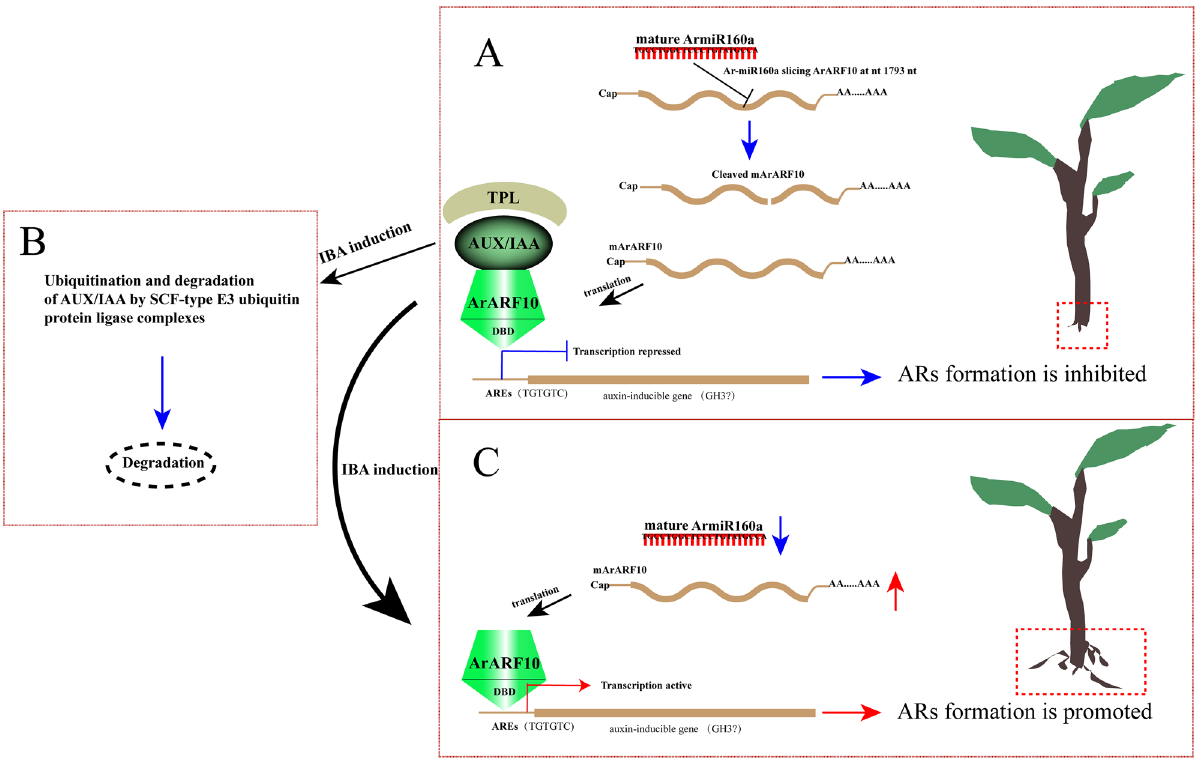
Figure 8. Schematic presentation of the regulation of AR growth in A. rubrum . ( A ) Under low auxin conditions, Ar-miR160 specifically cleaves mRNA- ArARF10 to repress ArARF10 expression, while Aux/IAA prevents auxin-inducible gene transcription by recruiting TPL to co-inhibit the binding of ArARF10 AREs in the auxin-inducible gene promoter. ( B ) Under increased levels of exogenous auxin, Aux/IAA is ubiquitinated and degraded by the SCF-type E3 ubiquitin protein ligase complex, and ArARF10 binds to AREs in the promoters of auxin-inducible genes to increase transcription. ( C ) The downregulation of Ar-miR160 also caused the translation of additional mRNA- ArARF10 into protein, as well as additional downstream functions that promoted AR